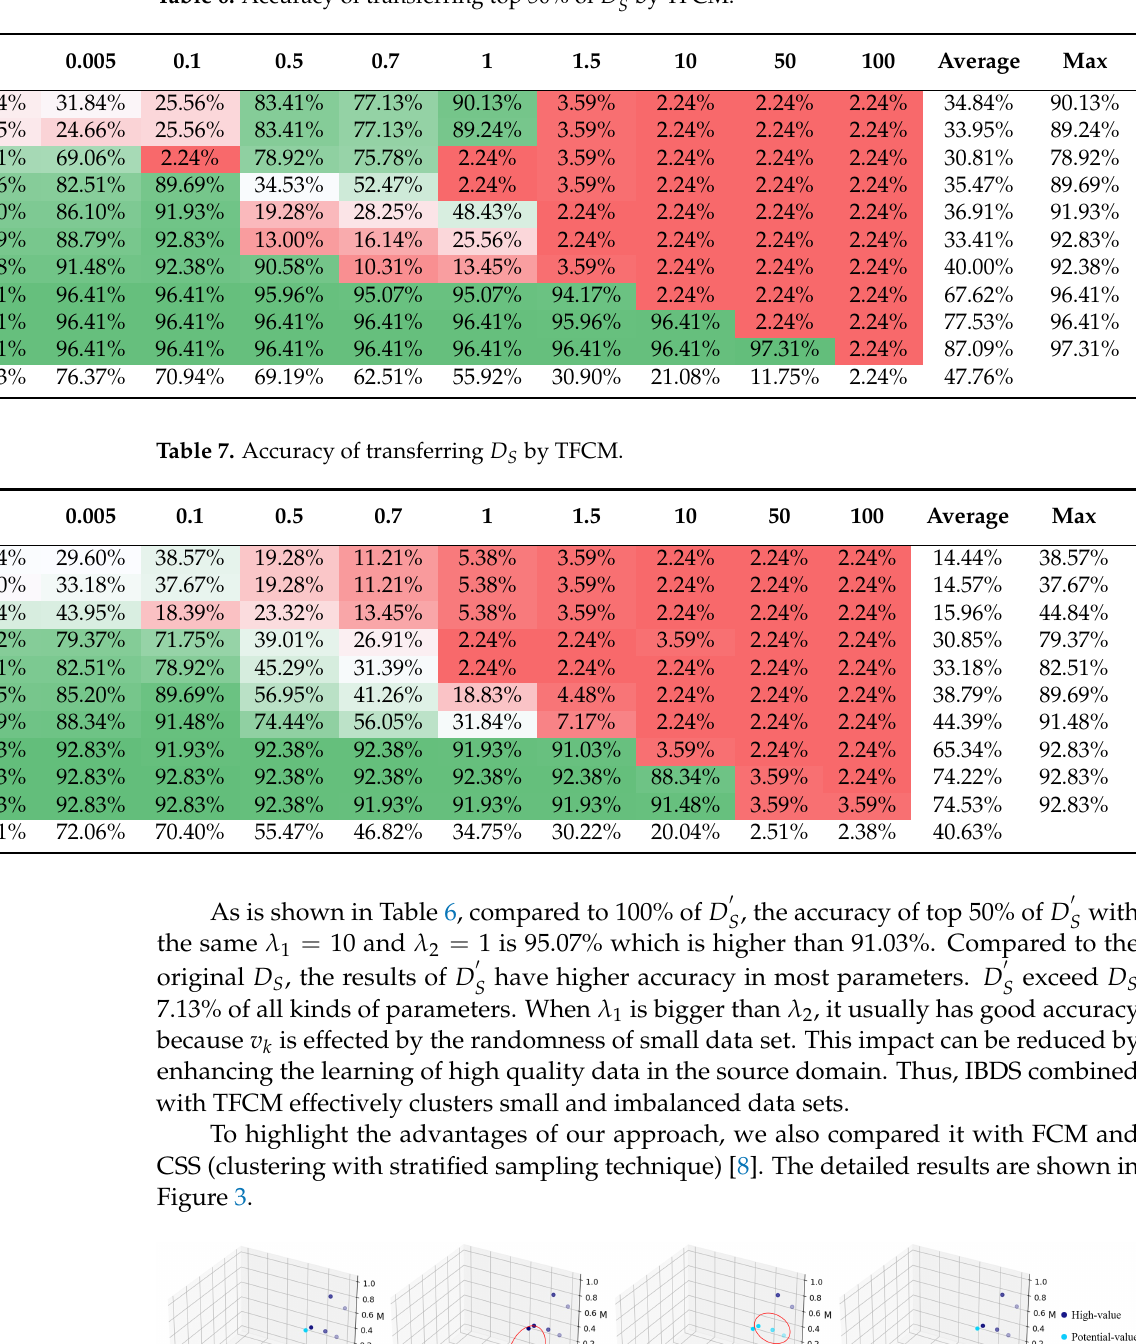
Table 6. Accuracy of transferring top 50% of D (cid:48)